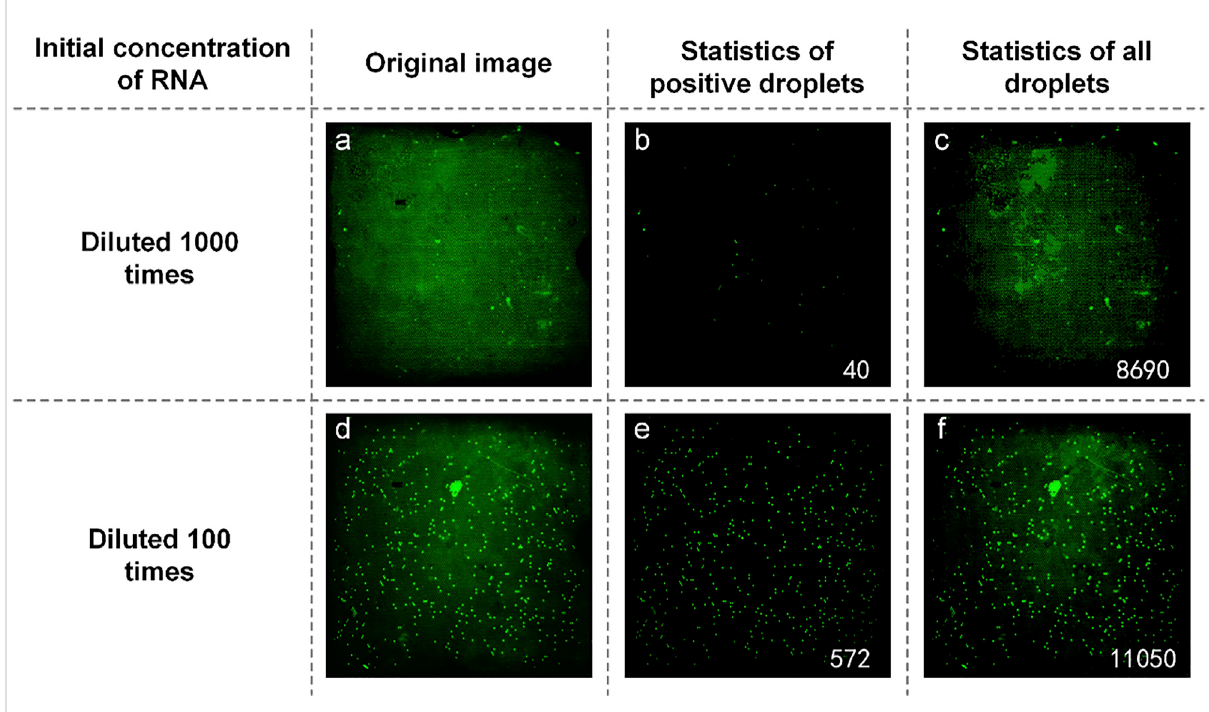
FIGURE 9 (A) Original image of SARS-COV-2 RNA with a concentration of diluted 1,000 times; (B) Image processed by software and the number of positive droplets with a concentration of diluted 1,000 times; (C) Statistics of all droplets containing SARS-COV-2 RNA with a concentration of diluted 1,000 times; (D) Original image of SARS-COV-2 RNA with a concentration of diluted 100 times; (E) Image processed by software and the number of positive droplets with a concentration of diluted 100 times; (F) Statistics of all droplets containing SARS-COV-2 RNA with a concentration of diluted 100